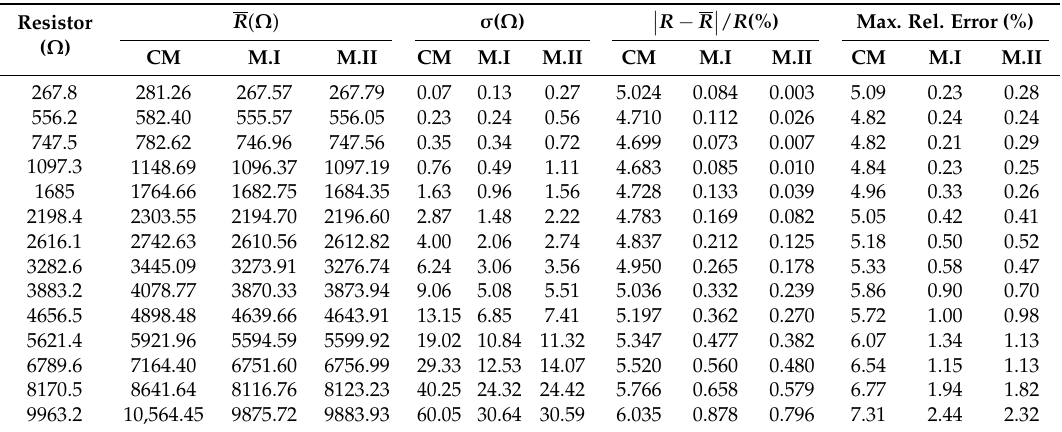
Table 2. Accuracy data for Rij estimation with a value of 270 Ω for the row and column of the resistor under test.